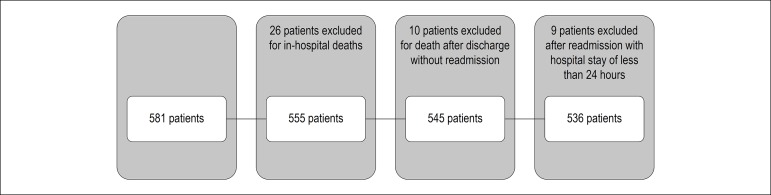
Flow chart of the occurrence of readmission within one year after the
first admission in patients with acute coronary syndrome.